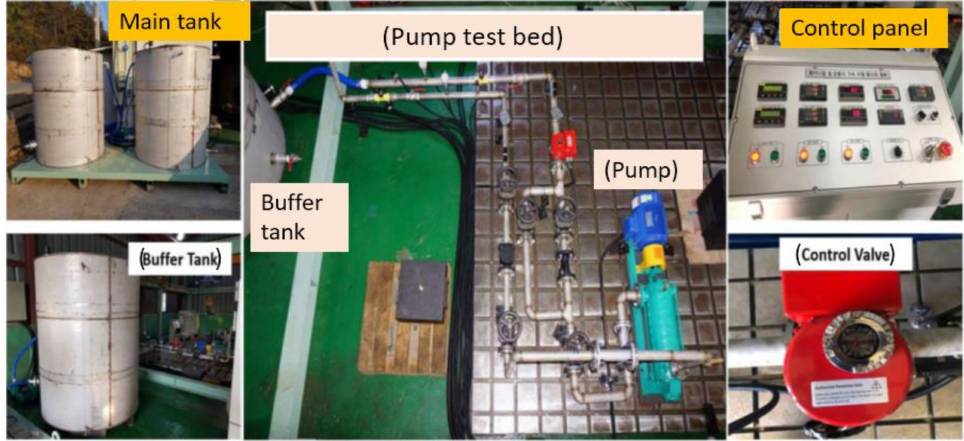
Figure 2. Experimental setup utilized for vibration data